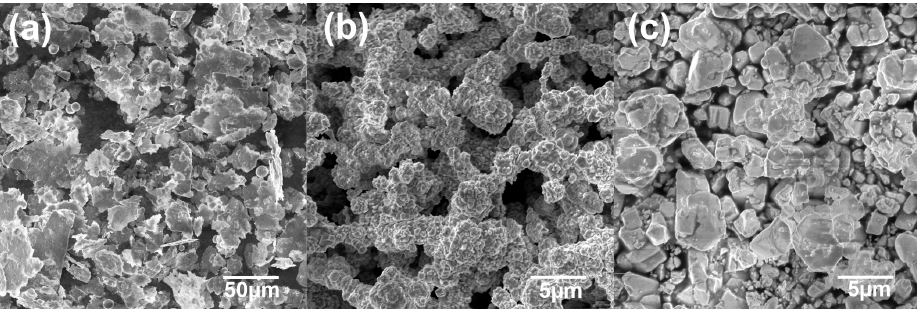
Figure 1. SEM microphotographs of Al ( a ), Ni ( b ) and WC ( c ) powder precursors. Table 1. Bulk sample indications.